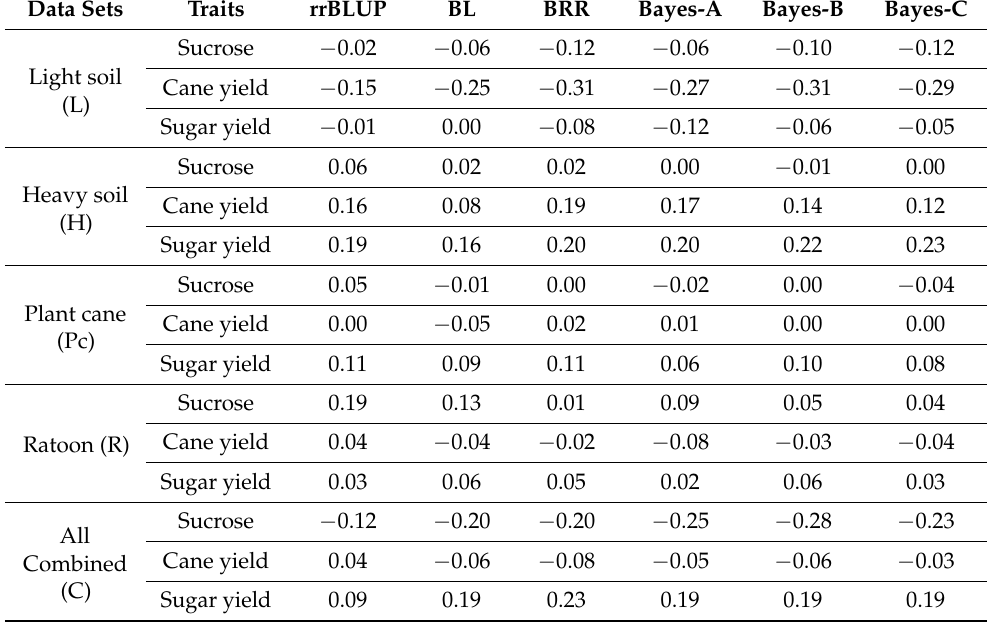
Table 1. The Pearson correlation between the actual (BLUEs) and predicted values (GEBVs) using various models on different